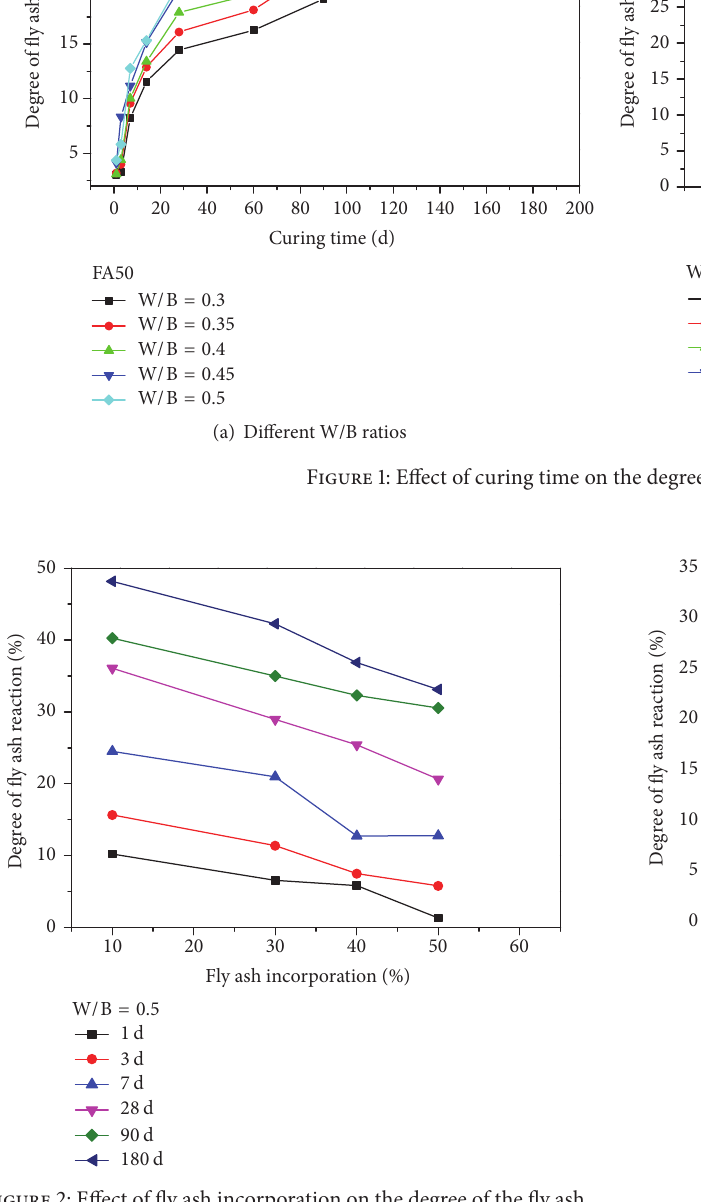
Figure 2: Effect of fly ash incorporation on the degree of the fly ash reaction.